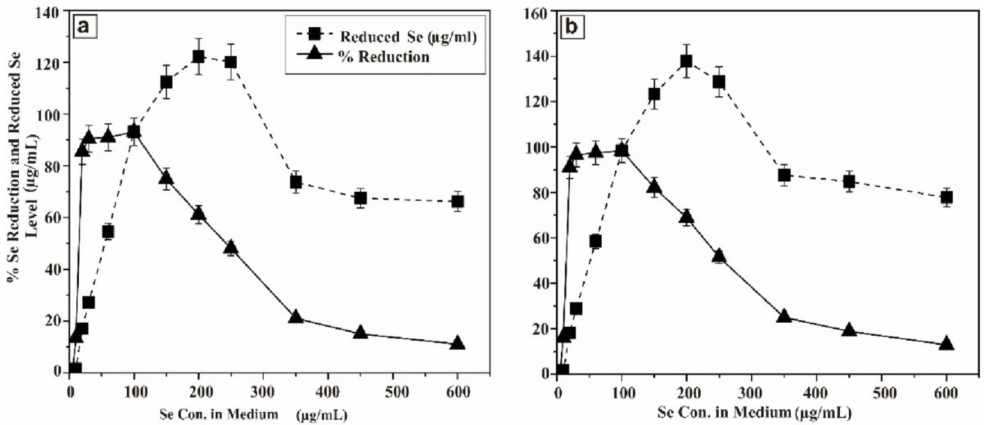
Figure 2. Se reducing capability of BSN313 at 24 h of incubation ( a ) and ( b ) Se reducing capability of BSN313 at 48 h of incubation.